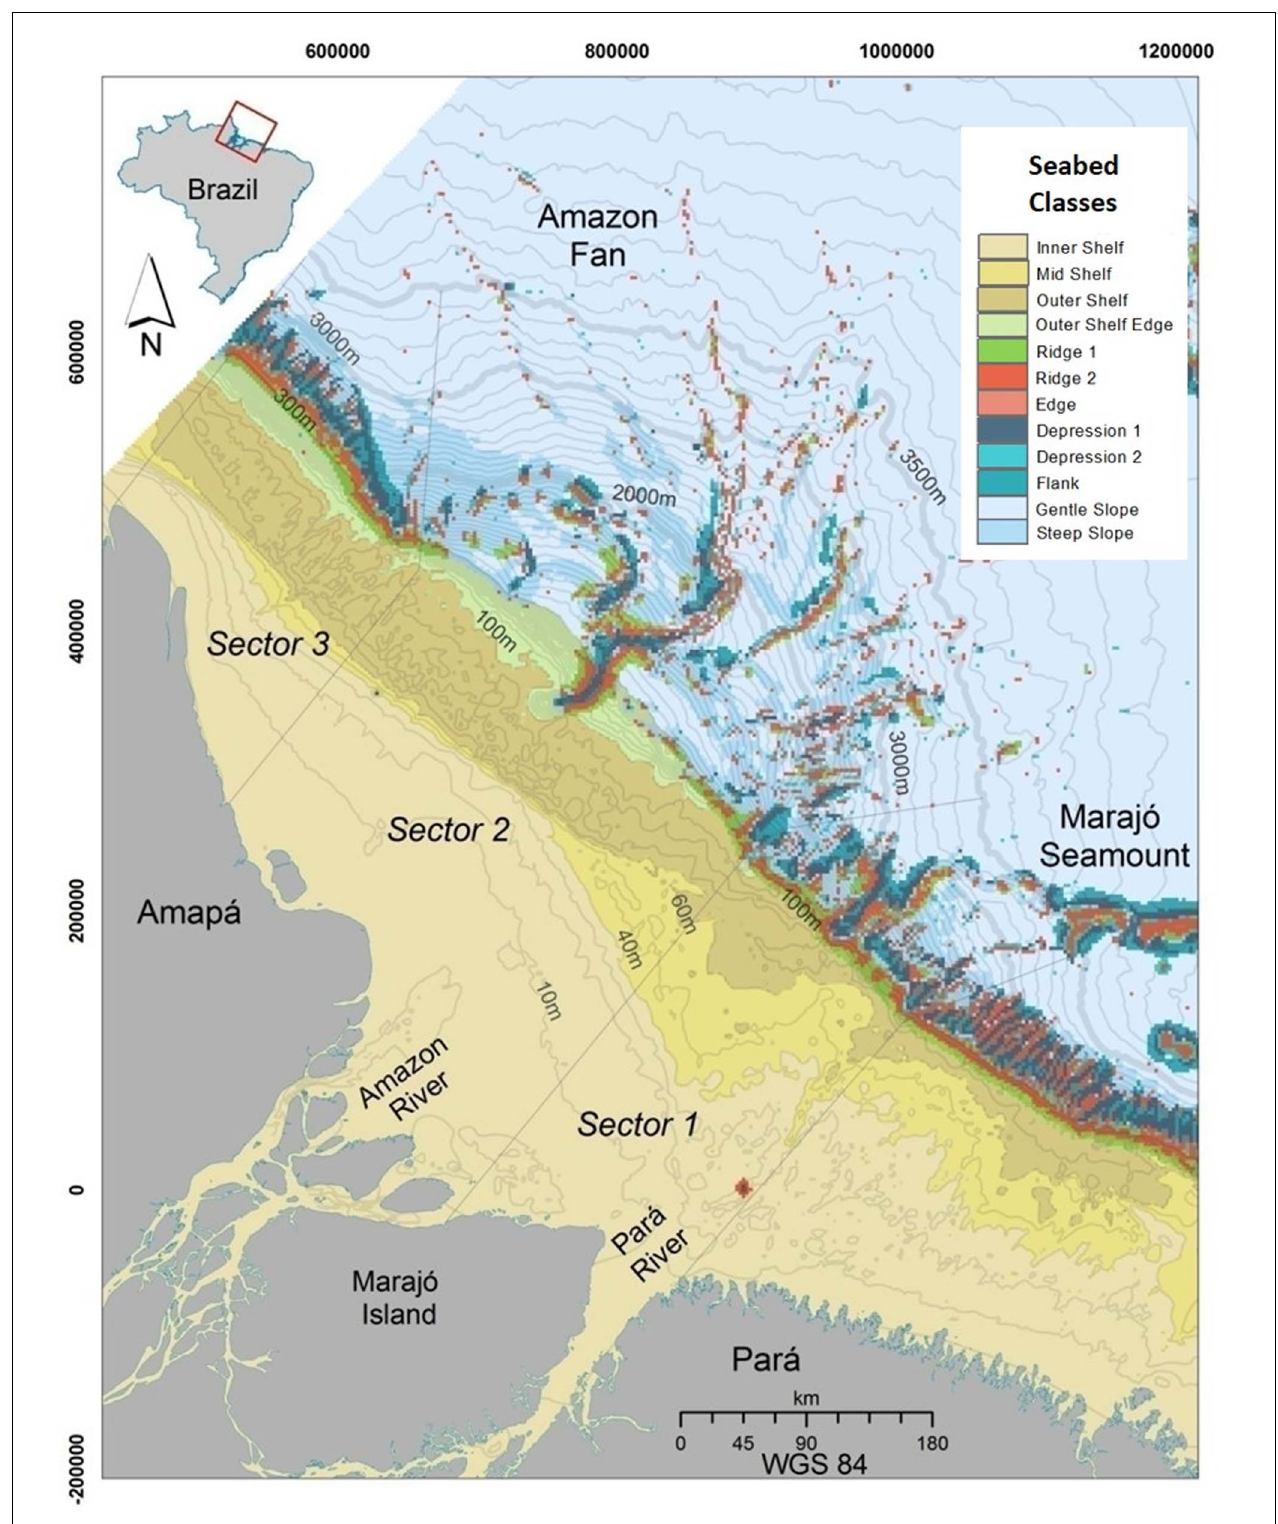
FIGURE 4 | Seabed geomorphometric classes defined with the Benthic Terrain Modeler (BTM). Isobaths are 10-m water depth spaced from the shoreline up to 300 m, and from then on, they are spaced at each 100-m interval (water depth). The thicker isobath represents 300 m, and the last one is set at 3,500 m (water